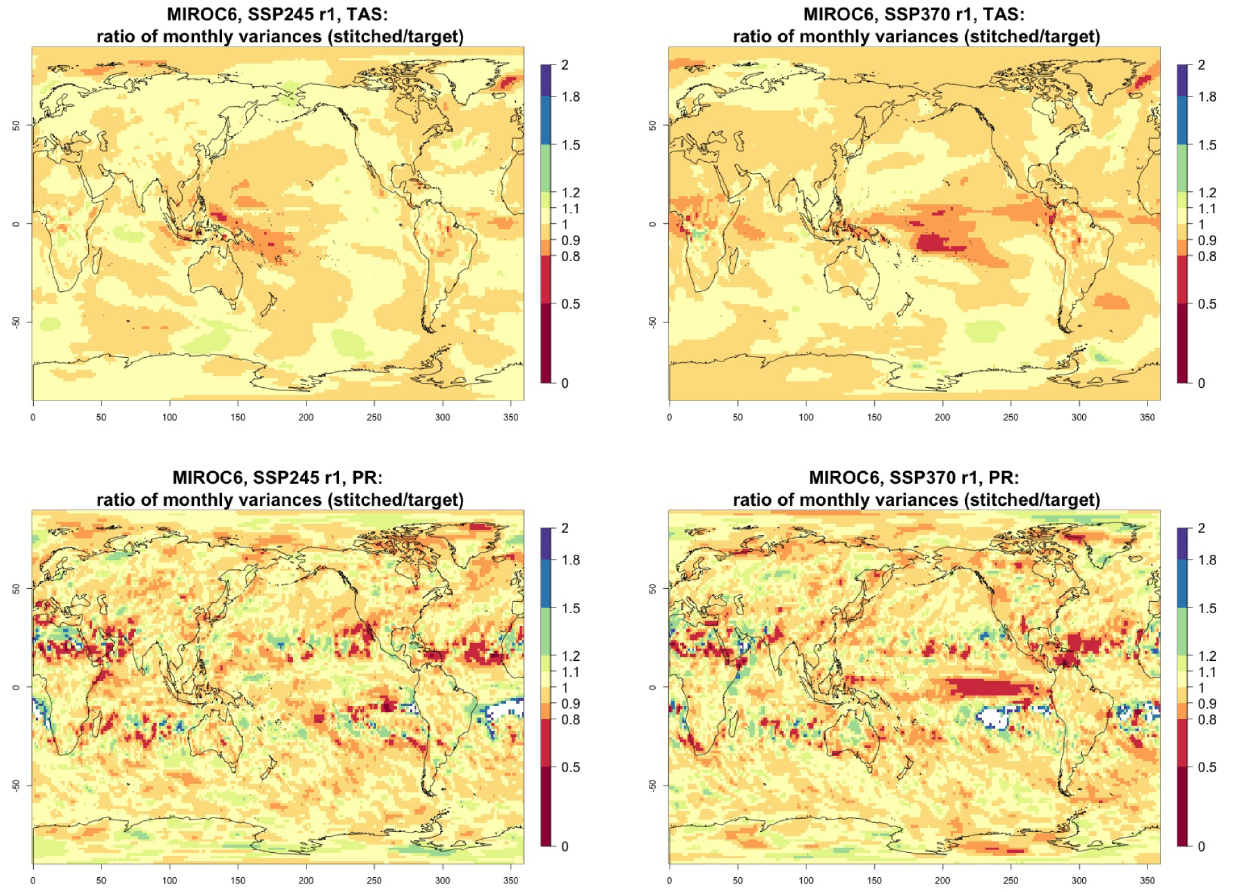
Figure C8. Ratio of monthly variability (standard deviation of residuals from trends) in temperature (TAS) and precipitation (PR) between stitched (at the numerator) and target (at the denominator) time series. The value of the ratio is expressed by the color scale, which highlights the transitions at 0.8 and 1.2. Emulation of MIROC6, monthly time series over 2015–2100, for SSP2-4.5 and SSP3-7.0. First realization.